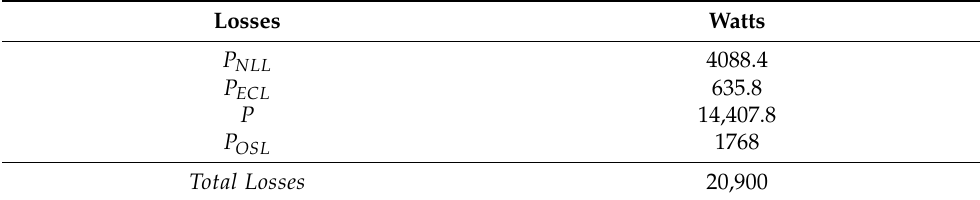
Table 1. Transformer standard design calculated losses.